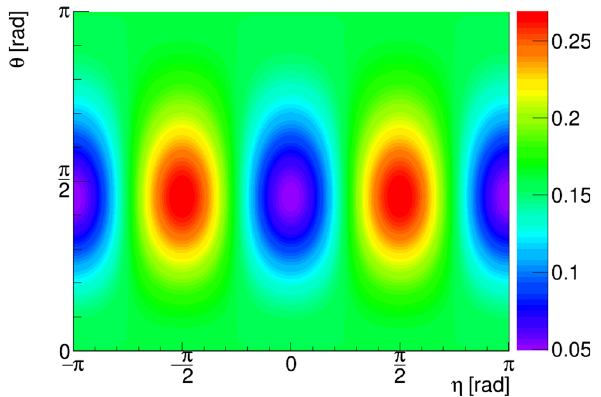
Fig. 5 PlotofthenormalizedKlein–Nishinarelation(4)independence of the scattering angle θ and the azimuthal angle η . For each scattering angle θ , corresponding to horizontal lines in the plot, we have normal- ized the probability as function of η . Around θ = 81 . 66 ◦ the biggest variation is found